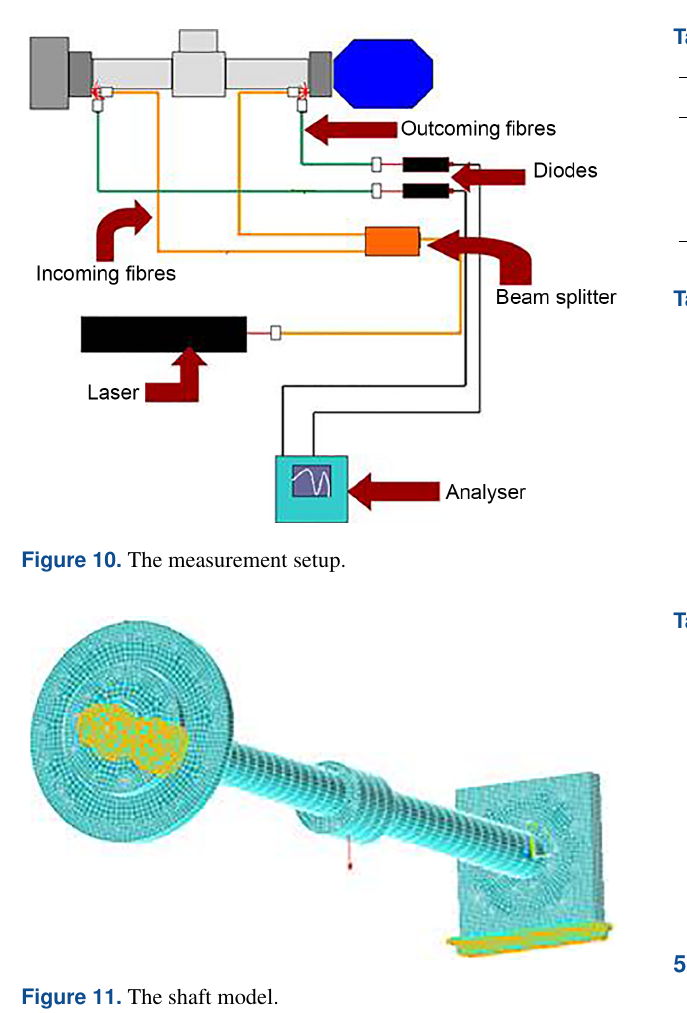
Figure 11. The shaft model.